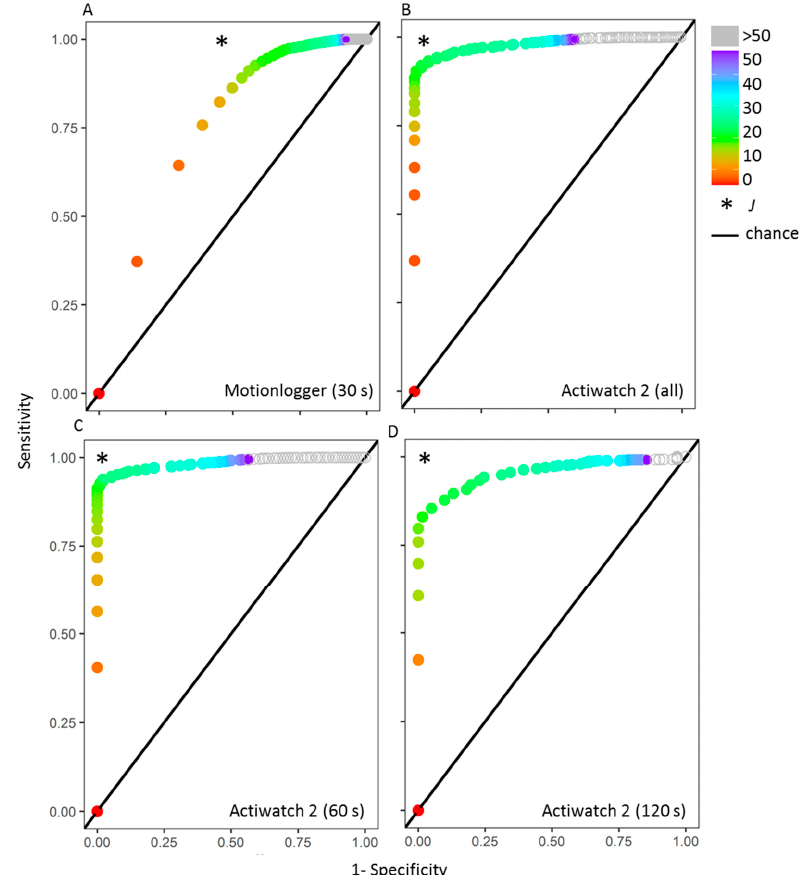
Figure 2. ROC analysis of correctly identified off-wrist and inactivity periods. Data are plotted as 1-specificity (inverse of the classification accuracy of off-wrist) versus sensitivity (classification accuracy of inactive) with each point representing a different threshold (color-coded). Data are shown for the Motionlogger ( A ) and Actiwatch 2 ( B ), as well as for the separate collection frequencies of the Actiwatch 2—60 s ( C ) and 120 s epochs ( D ).